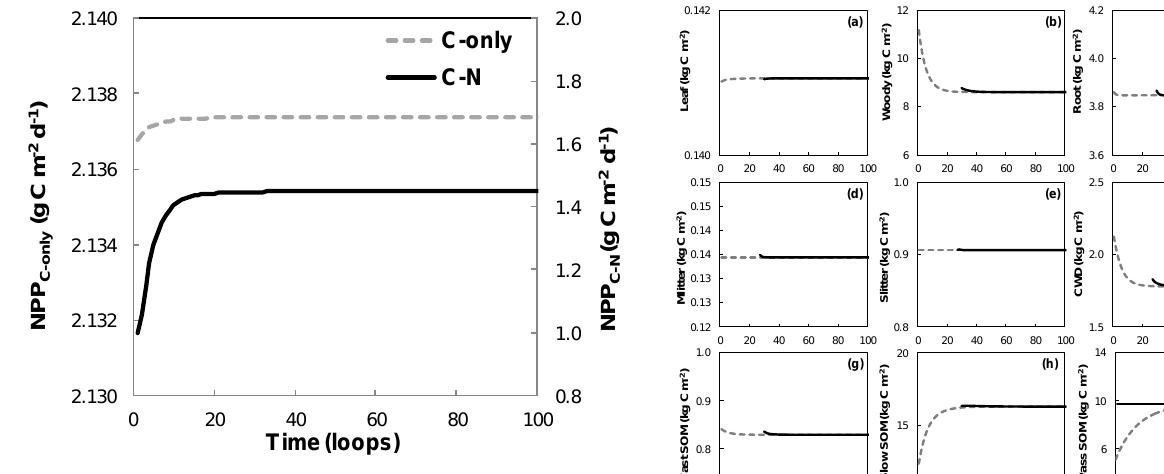
Fig. 3. Dynamics of NPP in the carbon-only (C-only; NPP C-only ) and coupled carbon–nitrogen (C-N; NPP C-N ) simulations with Har- vard Forest data.